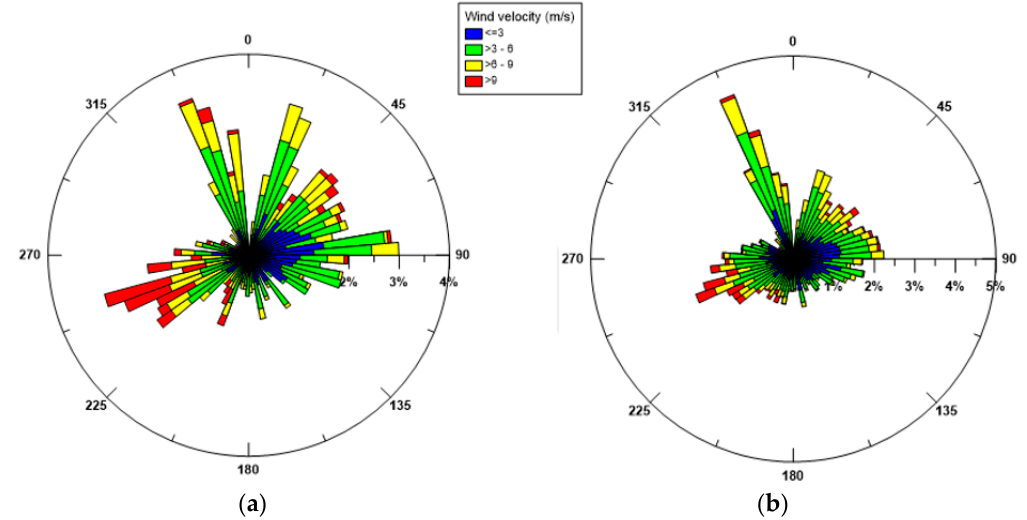
Figure 3. Wind polar diagrams for 2015: ( a ) winter; ( b ) summer. Incoming wind directions are shown.